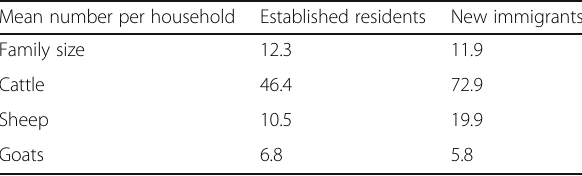
Table 3 Mean human and animal population at level of